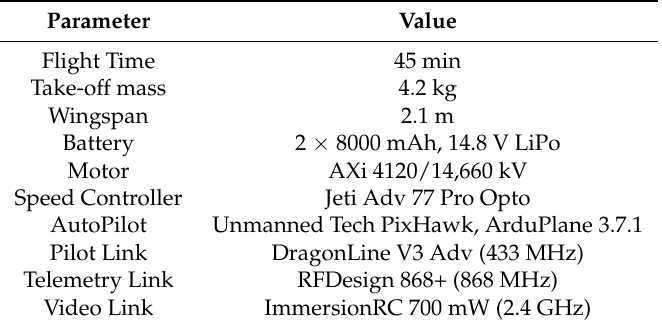
Table 1. Skywalker X8